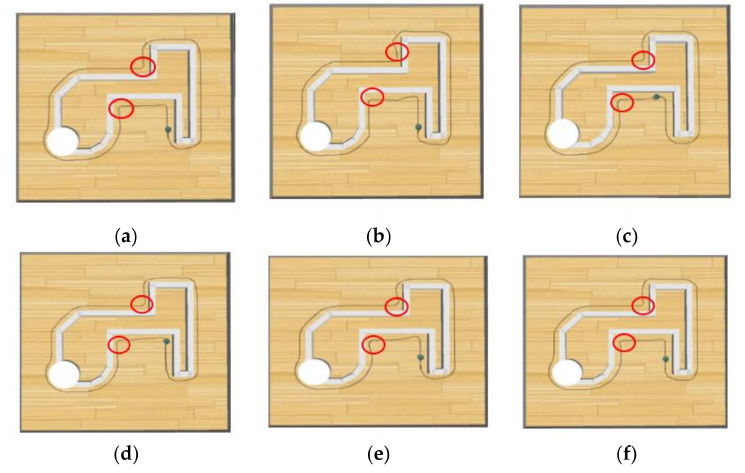
Figure 20. Moving path of setting 1 of ( a ) DGCPSO, ( b ) ABC [22], ( c ) WOA [23], ( d ) DE [24], ( e ) PSO [25], and ( f ) QPSO